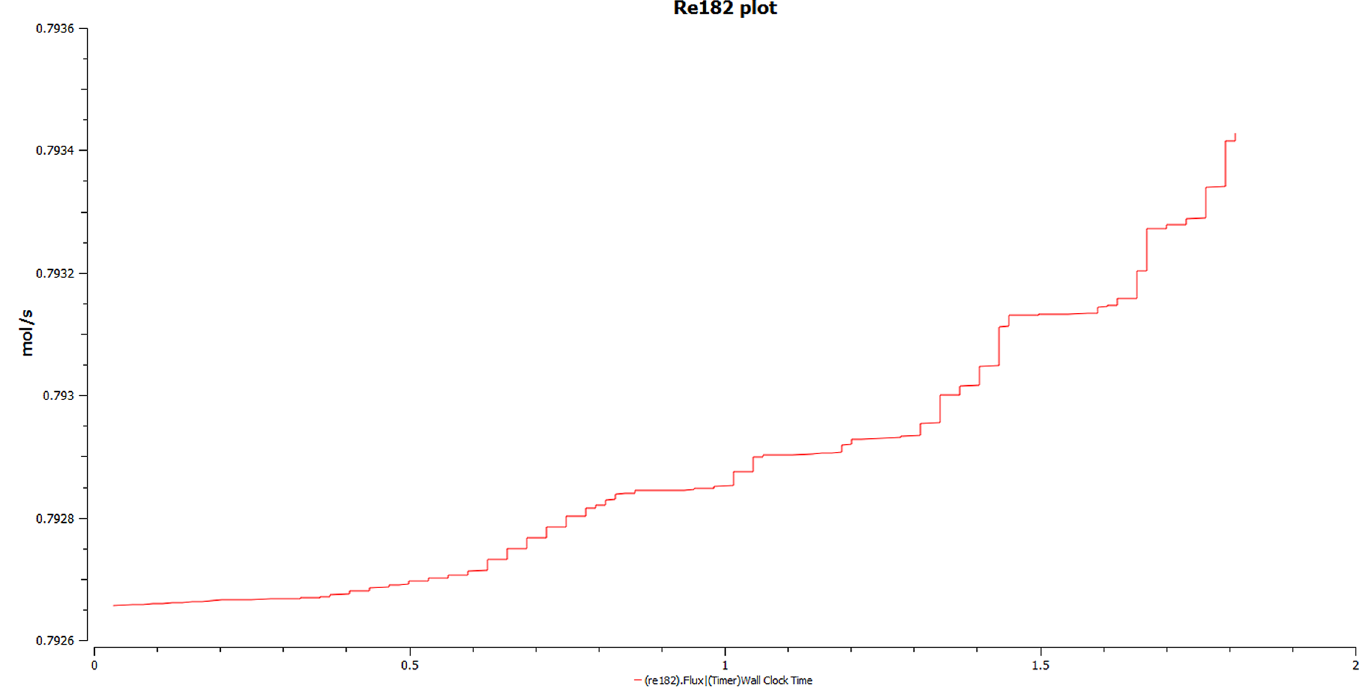
Fig 15. Simulation of the buffering of Creatine phosphate. Reaction 182 demonstrates an exponential steps plot, which signifies the role of creatine phosphate as an energy buffer system. During the need of energy in the system, there is synthesis of ATP and a reversal of the reaction to give ADP by creatine kinase. The buffer-ability of the system is maintained duly by the synergistic role of ATP-ADP and a feedback by the krebs cycle accomplishes the need of the cell for